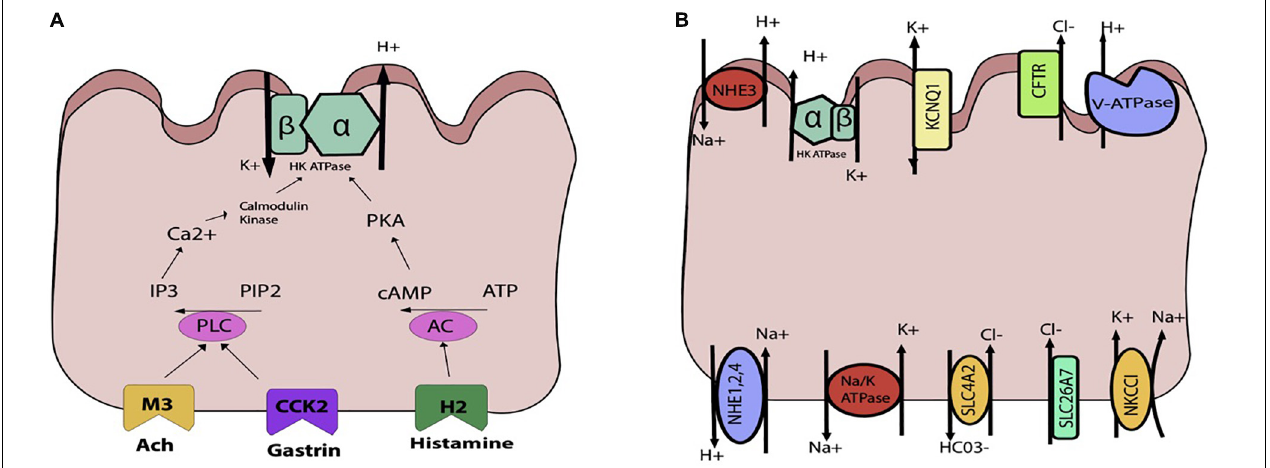
FIGURE 4 | Schematic representations of the parietal cell (A) gastric acid stimulants (B) exchangers, transporters, channels. (A) The H, K ATPase is stimulated through three primary inputs: acetylcholine (ACh), gastrin, and histamine. ACh and gastrin bind to their receptors and trigger activation of phospholipase C (PLC), which converts PIP2 to IP3 and triggers release of Ca 2 + from the sarcoplasmic reticulum. This leads to downstream activation of the H, K ATPase. Histamine binds to the H2 receptor, triggering activation of adenylyl cyclase and activation of PKA. (B) Multiple apical and basolateral anion and cation movements occur to maintain the gradient and electroneutral transport of Hydrogen.